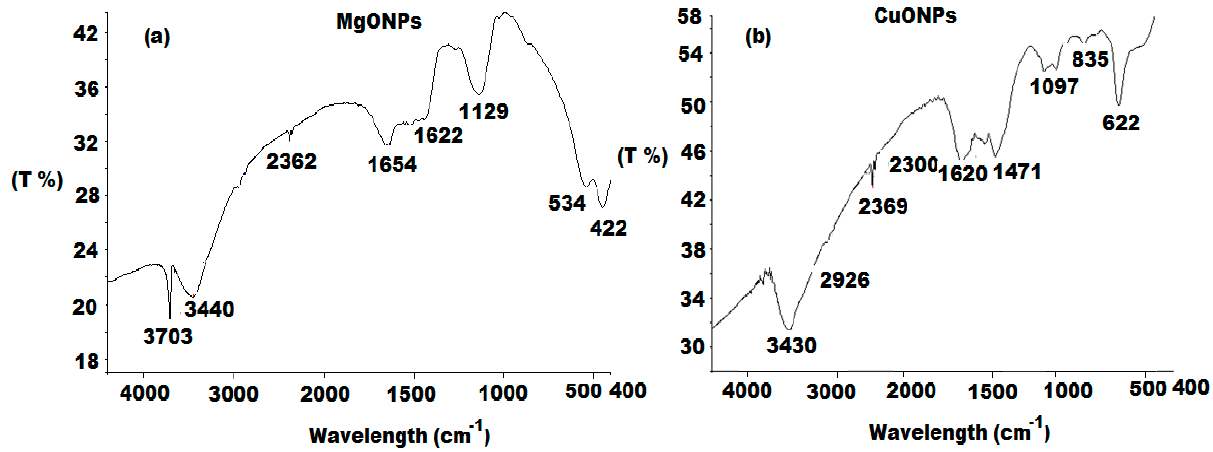
Figure 3. FT-IR spectra of synthesized ( a ) MgONPs and ( b ) CuONPs at a wavenumber range from 4000 to 400 cm − 1. For CuONPs, two well defined bands at 3430 and 2926 cm − 1 were observed and were